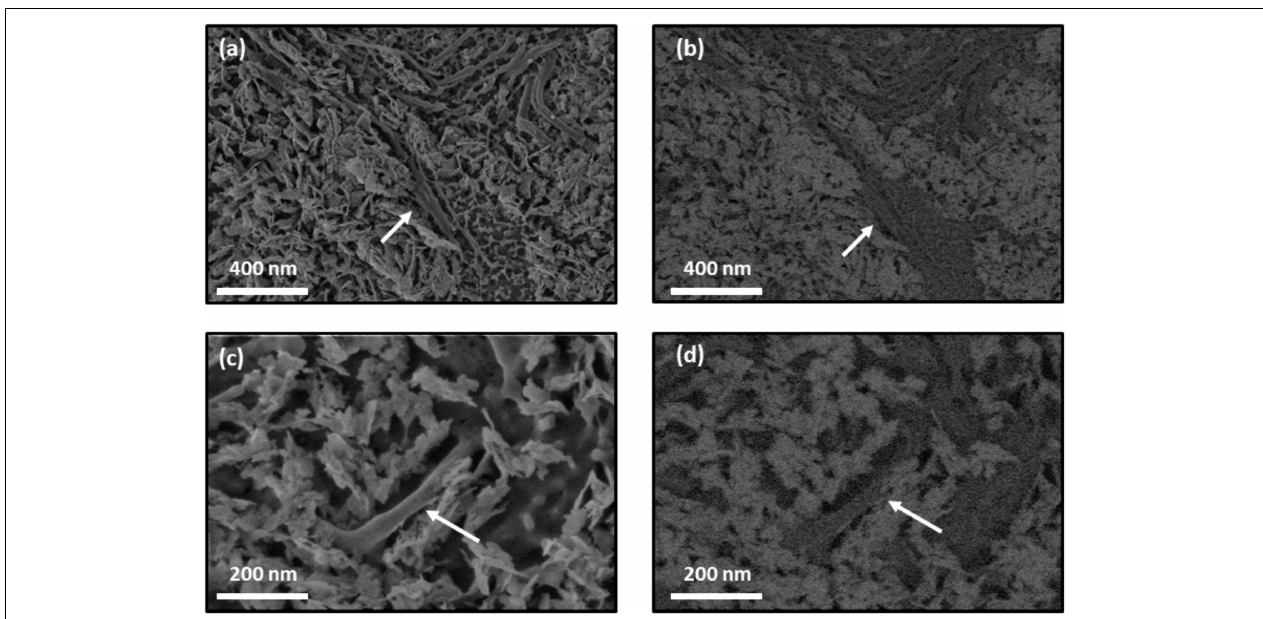
FIGURE 9 | Cryo-SEM images of collagen gel with calcium carbonate crystals. Collagen fibers treated with hrMMP-1 tightly interacted with aragonite crystals. (a,c) Secondary electron images of calcium carbonate with collagen fibers. (b,d) Back-scattered images of (a,c) , respectively. White arrows indicate collagen